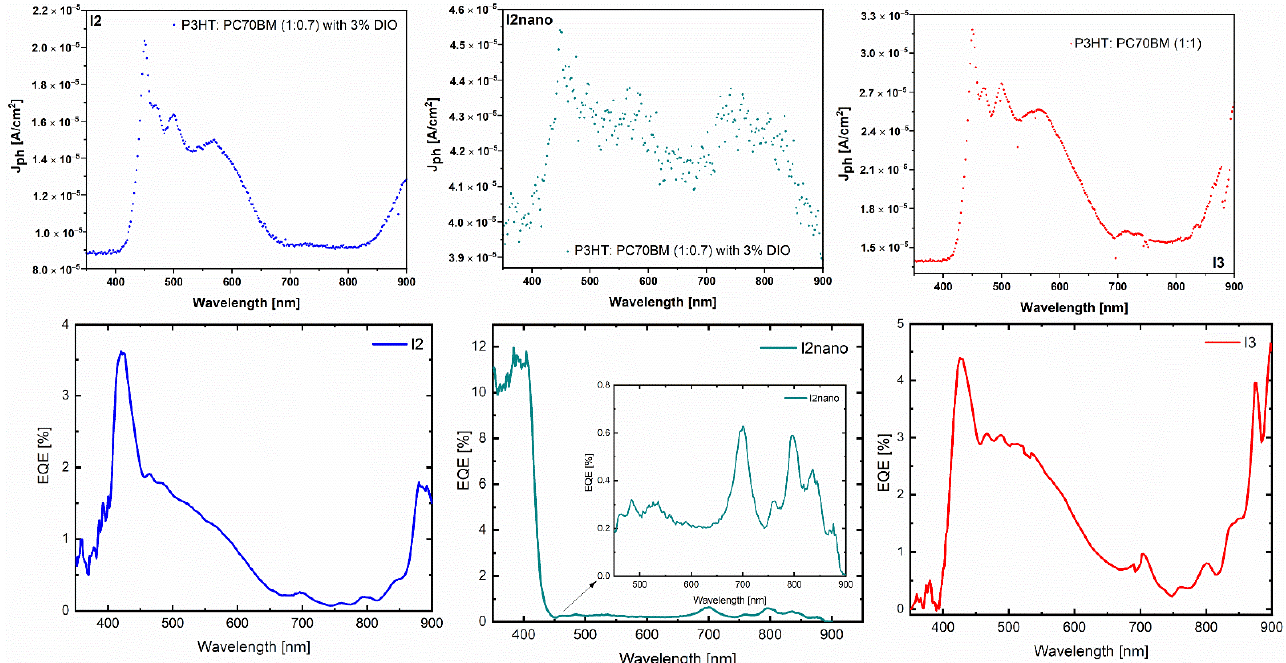
Figure 10. The photocurrent shape of the structures based on MAPLE-deposited organic layers on ITO and ITO micro-patterned electrodes and their external quantum efficiency (EQE) dependence on the incident wavelength (bottom part of the figure).